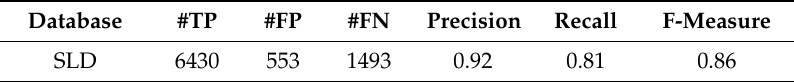
Table 5. Experimental results by our method with the SLD